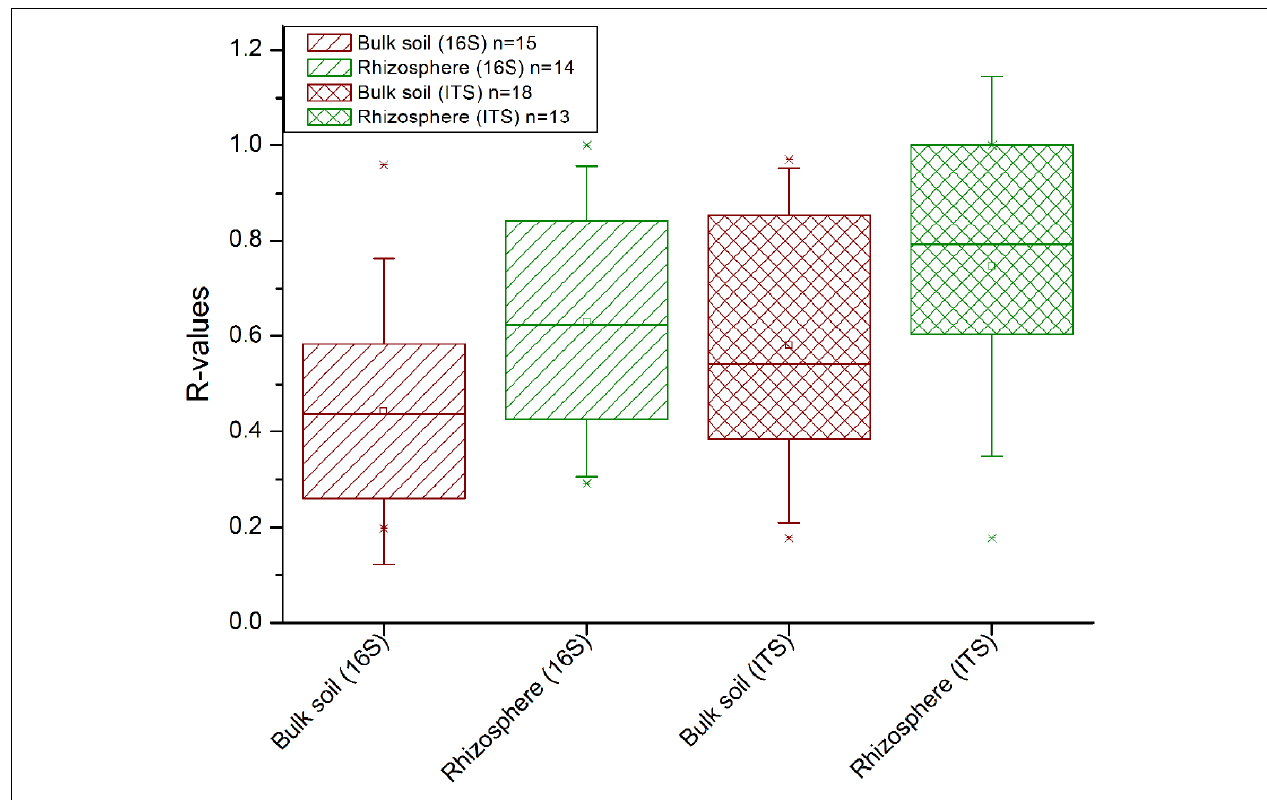
FIGURE 5 | Influence of straw treatment on the bacterial (16S) and fungal (ITS1) community composition in the rhizosphere and bulk soil. Data from each field, each compartment and of every time point were analyzed separately by ANOSIM. All significant R -values from this analysis (as shown in Supplementary Table 4) are included in this plot. Between 62 and 78% of the R -values were significant ( P < 0.05) per group